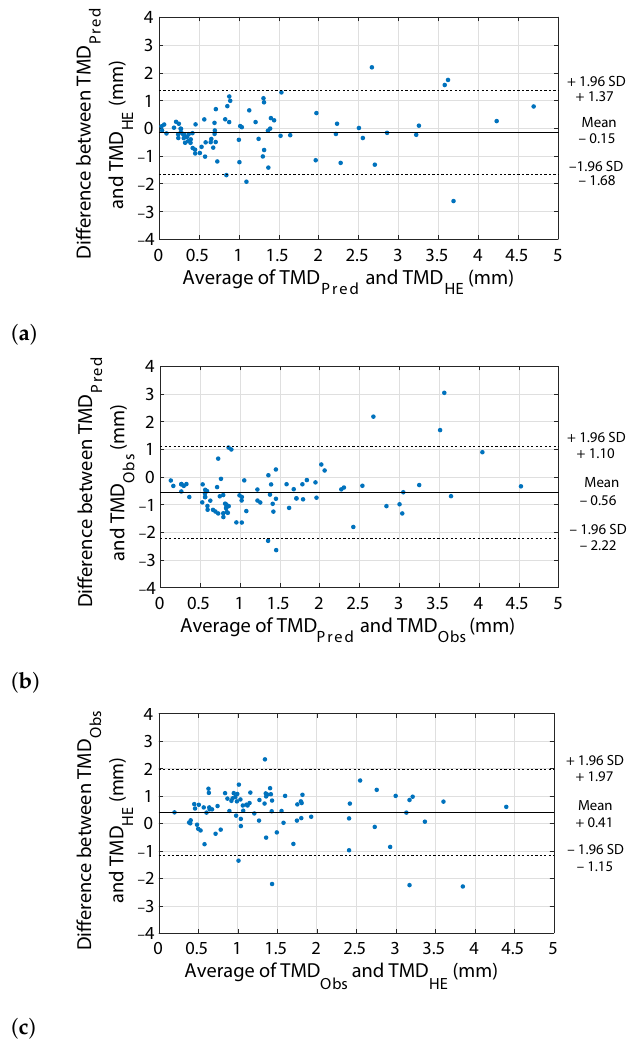
Figure 7. Bland-Altman plots of the agreement between ( a ) the TMD Pred and the TMD HE as a reference value, ( b ) the TMD Pred and the TMD Obs as a reference value, ( c ) the TMD Obs and the TMD HE as a reference value. Solid line: mean difference; dashed lines: 95% upper and lower limits of